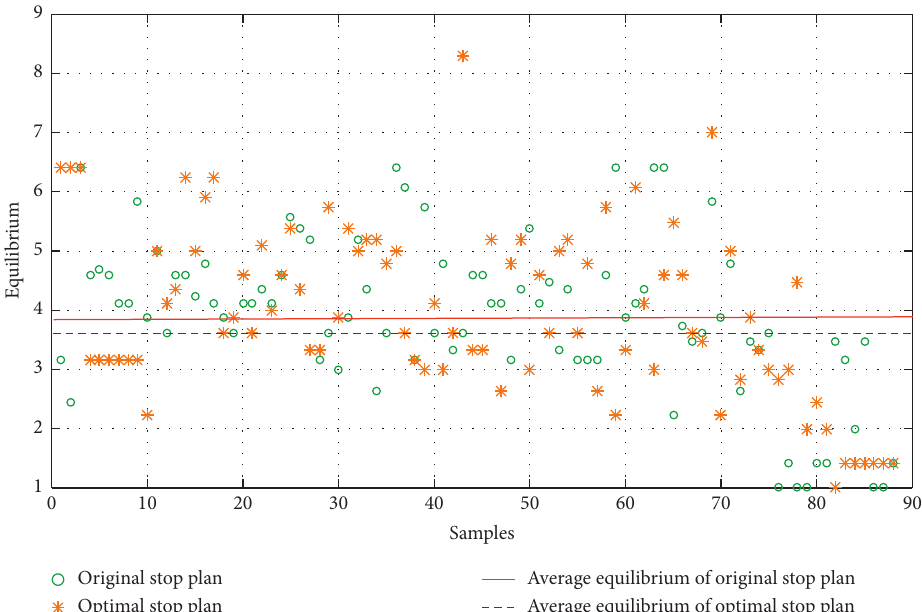
Figure 8: Average equilibrium of trains for original and optimal stop